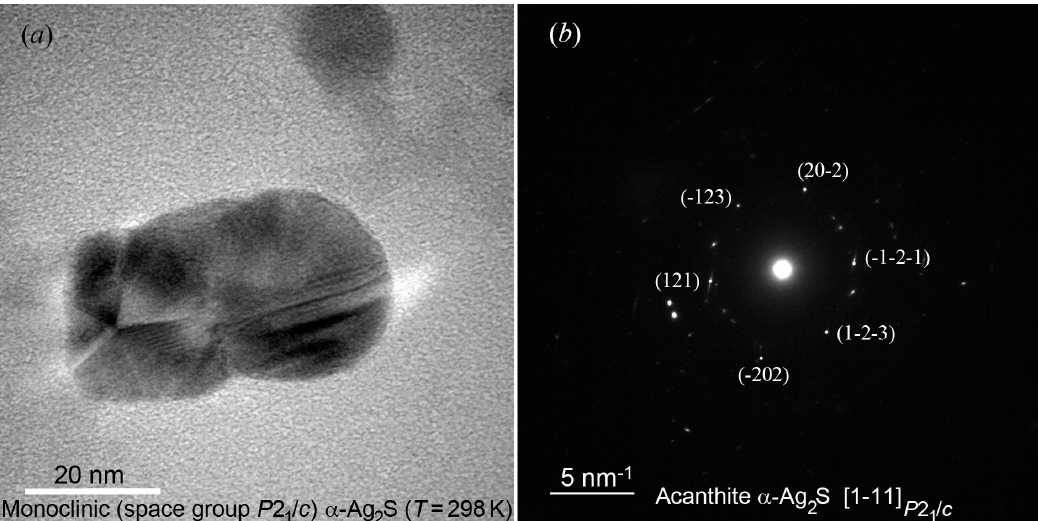
Figure 14. ( a ) HRTEM image of agglomerate of several silver sulfide nanoparticles and ( b ) electron diffraction pattern (the zone axis [ 1 − 11 ] ) of this image. Electron diffraction pattern contains the reflections corresponding to monoclinic (space group P 2 1 / c ) α -Ag 2 S acanthite. Colloid nanoparticle of α -Ag 2 S acanthite is shown in Figure 15a. The increased area